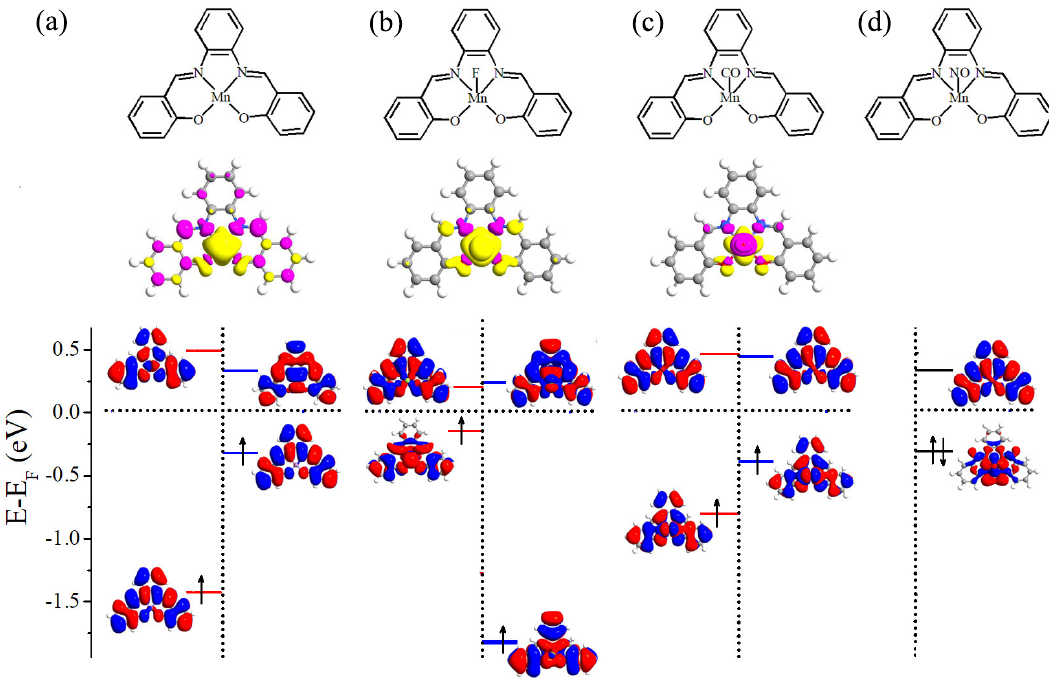
Figure 1. Schematic view of molecular geometric structure (top panel), spin density (middle panel), and the energy levels and the spatial distribution of the HOMO and LUMO (bottom panel). Here, ( a ) free Mn-salophen molecule, ( b – d ) Mn-salophen molecule with F, CO, and NO adsorptions. The short-dotted horizontal lines stand for the Fermi level, which is defined as the center place of the HOMO-LUMO gap of the spin-up or spin-down